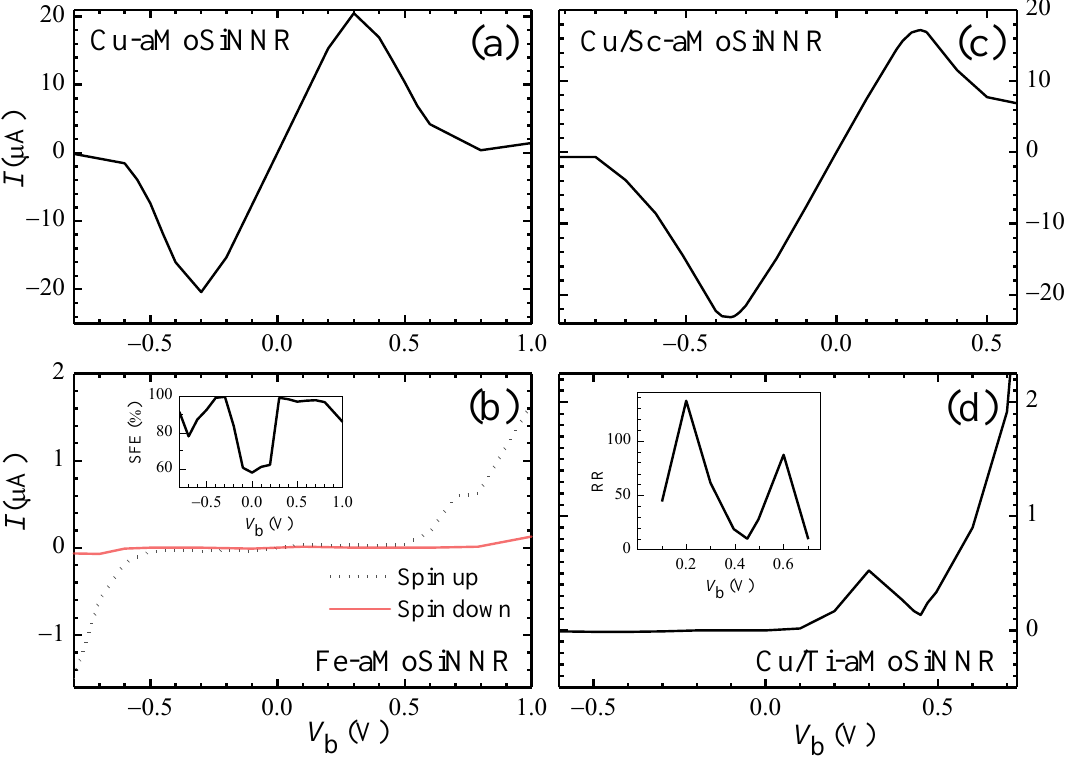
Figure 7. The I-V characteristics of two-probe device systems made of aMoSiNNR homojunctions doped by ( a ) Cu and ( b ) Fe elements, and heterojunctions doped by ( c ) Cu/Sc and ( d ) Cu/Ti elements at site 1. The spin filtering efficiency of the Fe homojunction and the rectification ratio of the Cu/Ti heterojunction are plotted as the insets of ( b ) and ( d ), respectively.